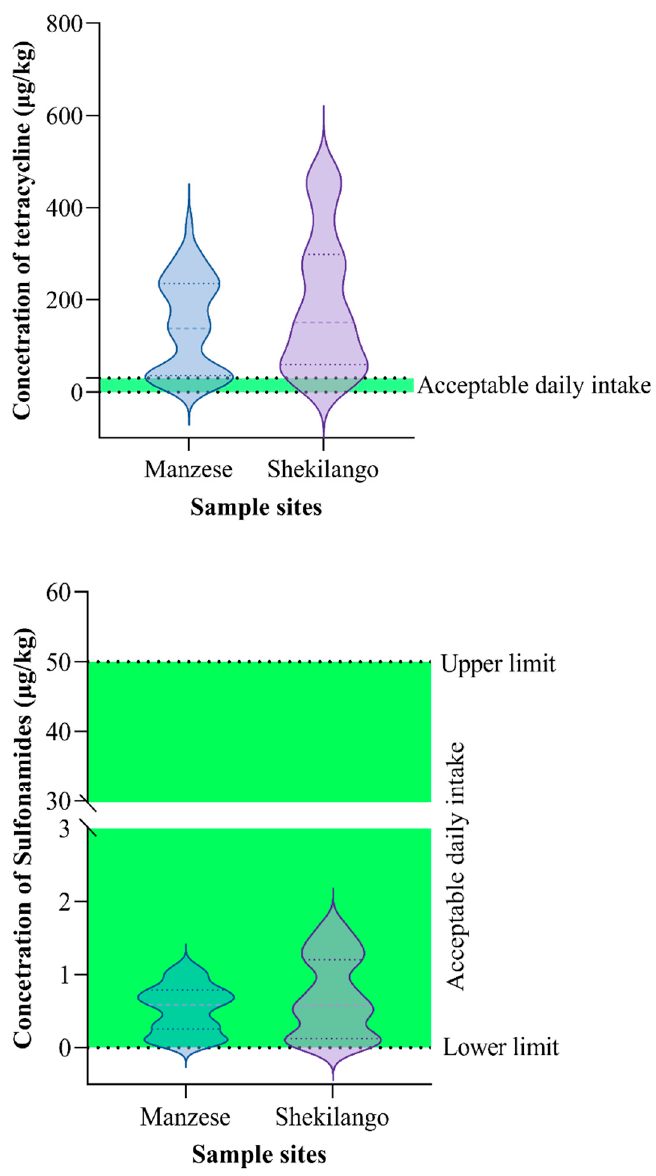
Figure 3. Comparison of concentrations of tetracycline and sulphonamide residues with acceptable daily intake (ADI).